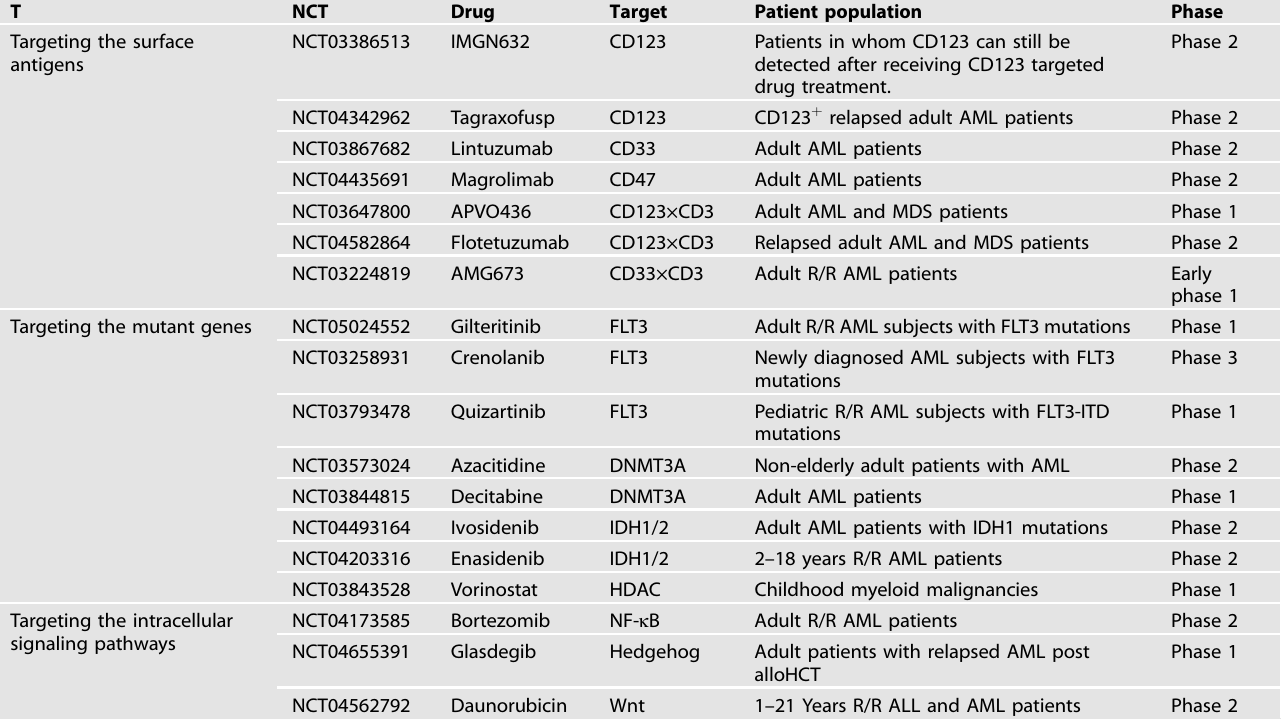
Table 2. Ongoing clinical trials evaluating novel targeted agents for